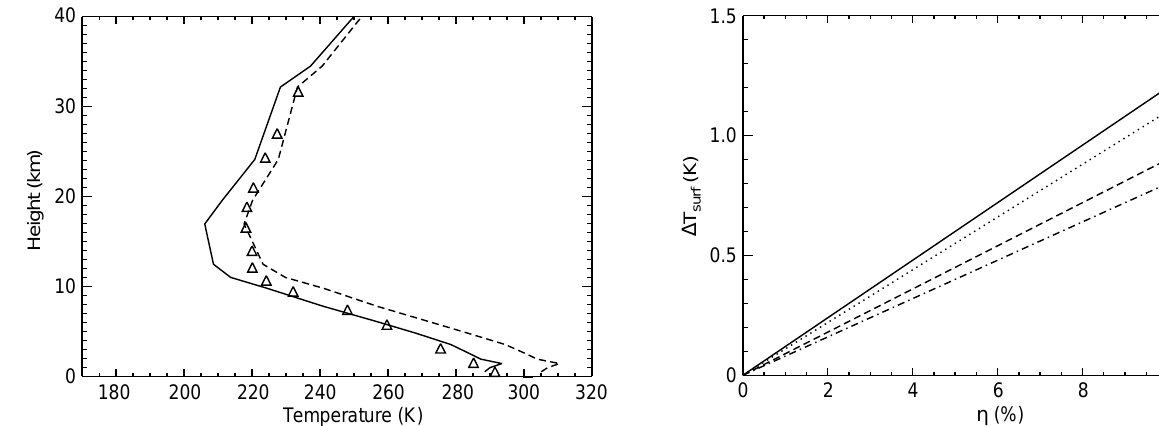
Fig. 9. Increase in surface temperature (cid:68) T surf in dependence on additional ice cloud cover (cid:103) due to contrails and cirrus in the case of mean July and October conditions over southern Germany. Solid : July, cirrus; dotted : July, contrails; dashed : October, cirrus; dash- dotted :